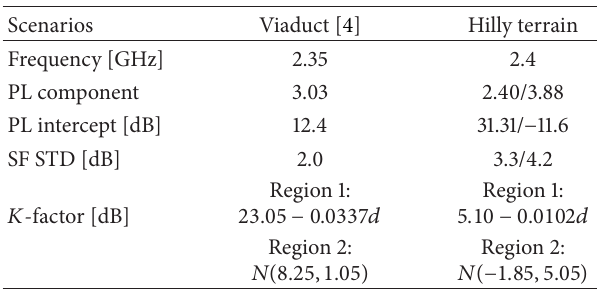
Table 4: 𝐾 -factor statistic in hilly terrain.